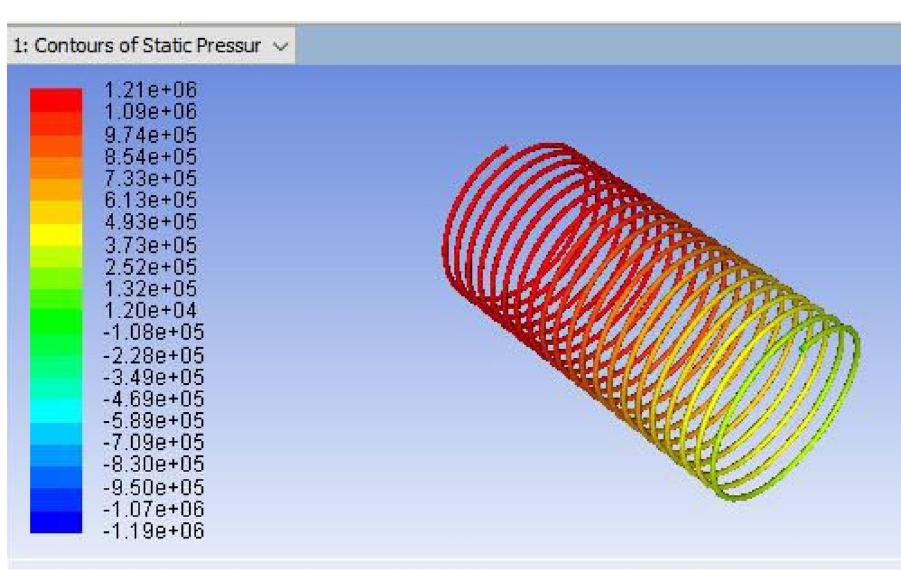
Figure 13. ANSYS Fluent solution of static pressure for capillary coil 1 (3.35